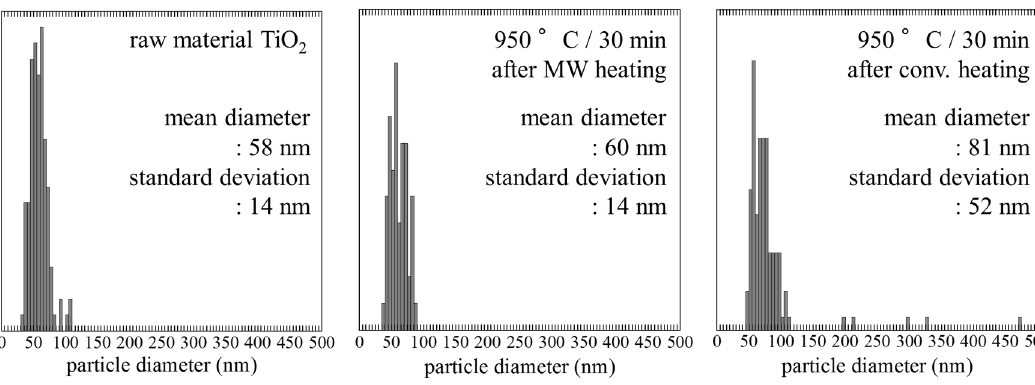
Figure 5. Histograms of particle diameter of the TiO 2 raw material and samples heated by microwave irradiation and conventional heating.